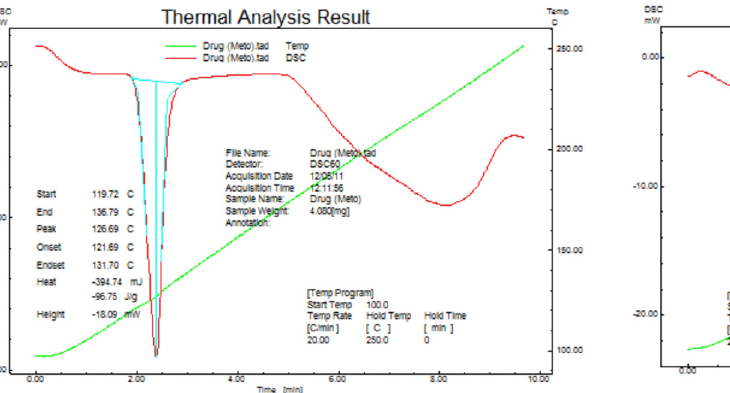
FIGURE 6 – DSC analysis of metoprolol tartrate. FIGURE 7 - DSC analysis of metoprolol tartrate with optimized FDT formulation.